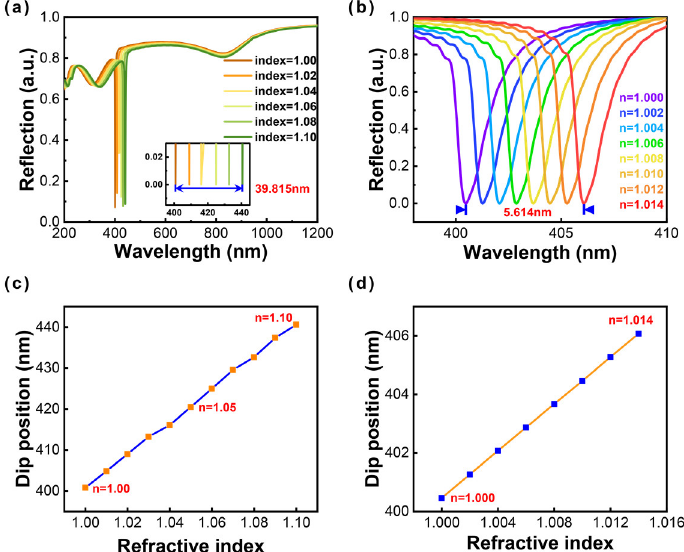
Figure 5. Reflectance spectra in different dielectric environments. The refractive index of the sur- rounding medium ranges ( a ) from 1.00 to 1.10 (the interval is 0.02); ( b ) from 1.000 to 1.014 (the interval is 0.002). The variation of dip position for two situations with the refractive index ranges ( c ) from 1.00 to 1.10 (at 0.01 intervals); ( d ) from 1.000 to 1.014 (at 0.002 intervals). The evaluation of sensing typically refers to the sensitivity and figure of merit (FOM).